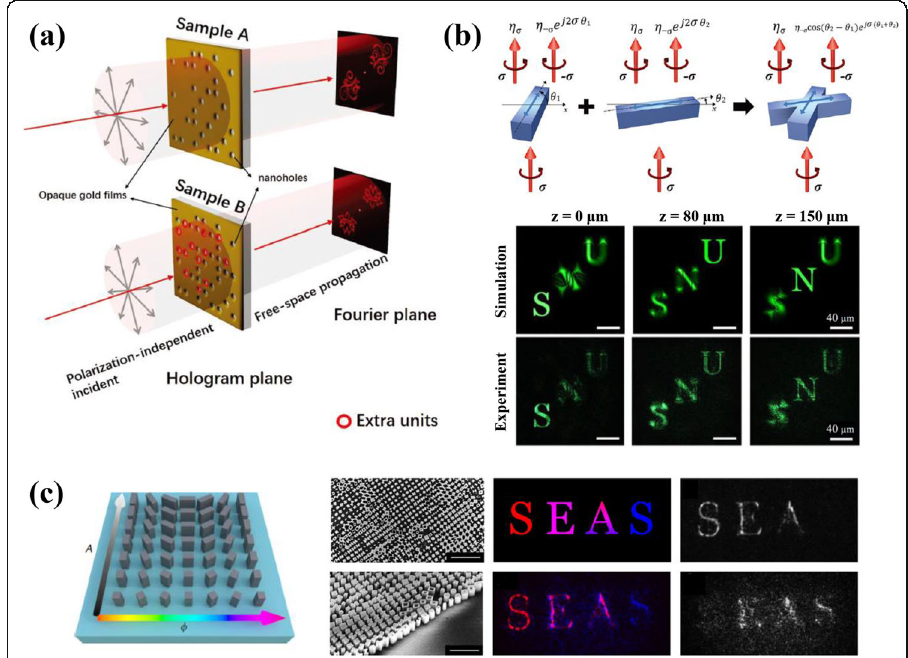
Fig. 1 Amplitude-only holography and complex amplitude holography based on metasurfaces. a Schematic illustrations of demonstrated photon sieves. Two completely different holographic images can be reconstructed through quantitatively correlated amplitude modulations [10]. b Complex amplitude holography based on dielectric metasurfaces composed of X-shaped meta-atoms. The principle is shown on the top panel. The simulated and experimental results of proposed complex amplitude hologram are shown on the bottom panel [59]. c Dielectric metasurfaces composed of amorphous silicon ( α -Si) nanofins with different sizes and orientation angles for complete and independent control of complex amplitude under circular polarization illumination. The scanning electron micrograph (SEM) images of fabricated metasurfaces are shown on the middle. Complex amplitude modulation can be obtained at two different frequencies and result in the reconstruction of holographic images